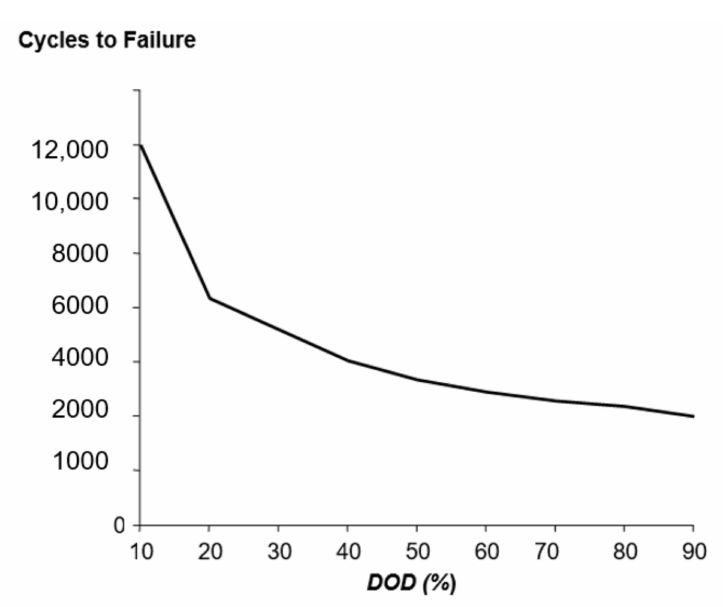
Figure 4. Lead-acid battery: cycles to failure vs. depth of discharge (DOD)